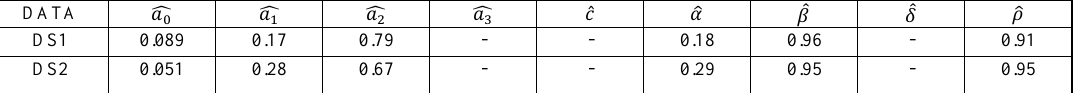
Table 1. The result of parameter estimation (bivariate C-D Weibull model)